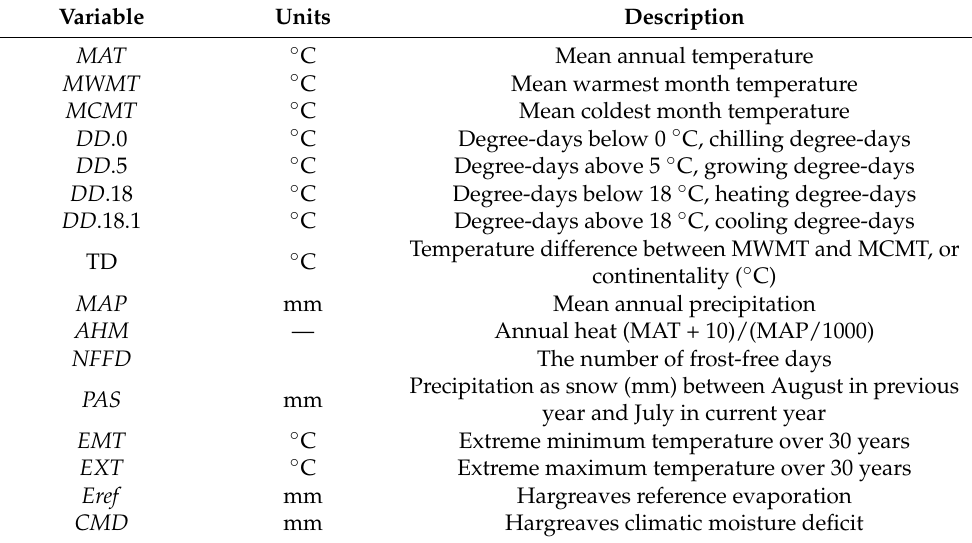
Table 3. List of abbreviations and explanation of available climate variables for BCEF s models. The mean values of climate variables over each survey interval (30 years) for the period from 1981 to 2010 were